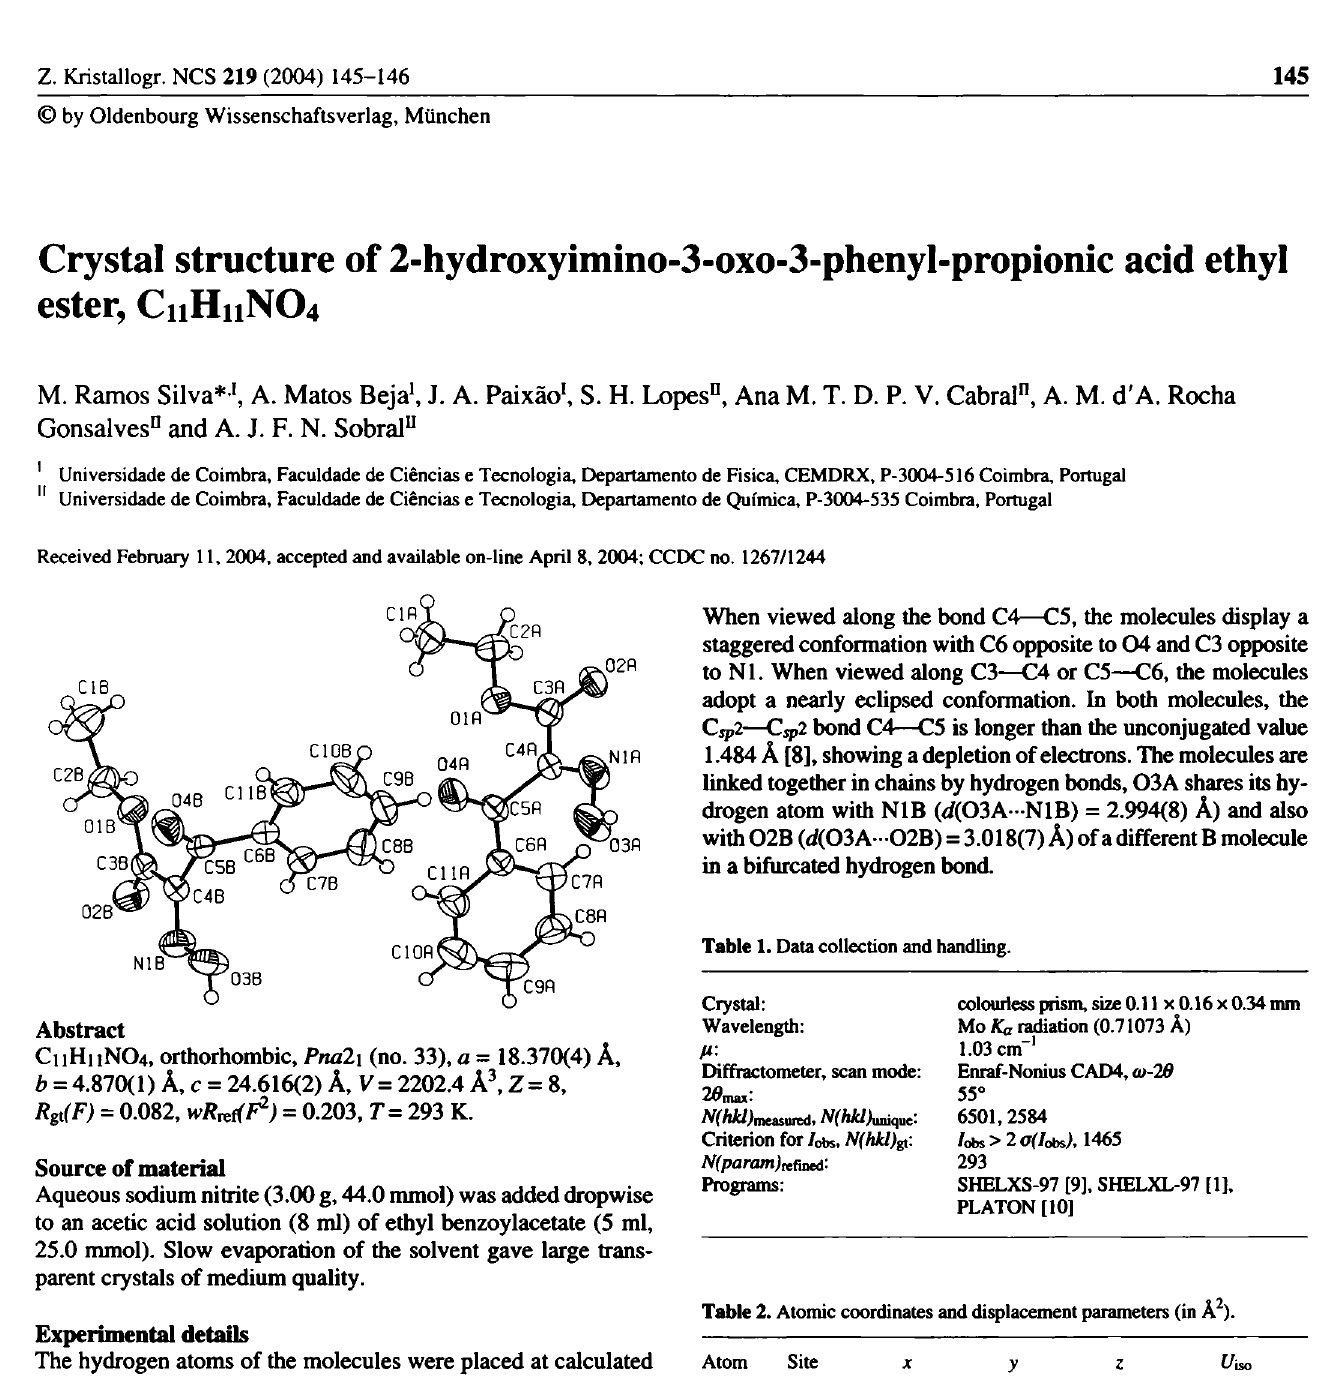
Table 2. Atomic coordinates and displacement parameters (in Á 2